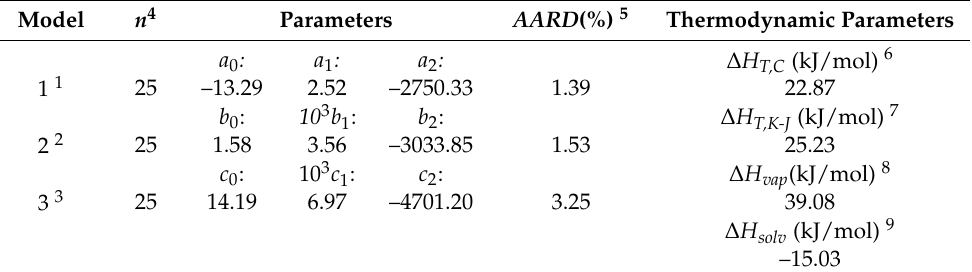
Table 3. The fitted solubility parameters of three density-based models and the approximate heat of vaporization, total heat of solution and heat of solvation for P. frutescens oils obtained by dynamic SC CO 2